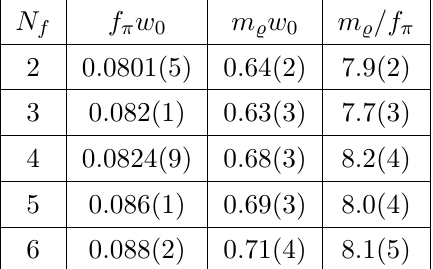
Table 1 . Continuum results for each N f in the chiral